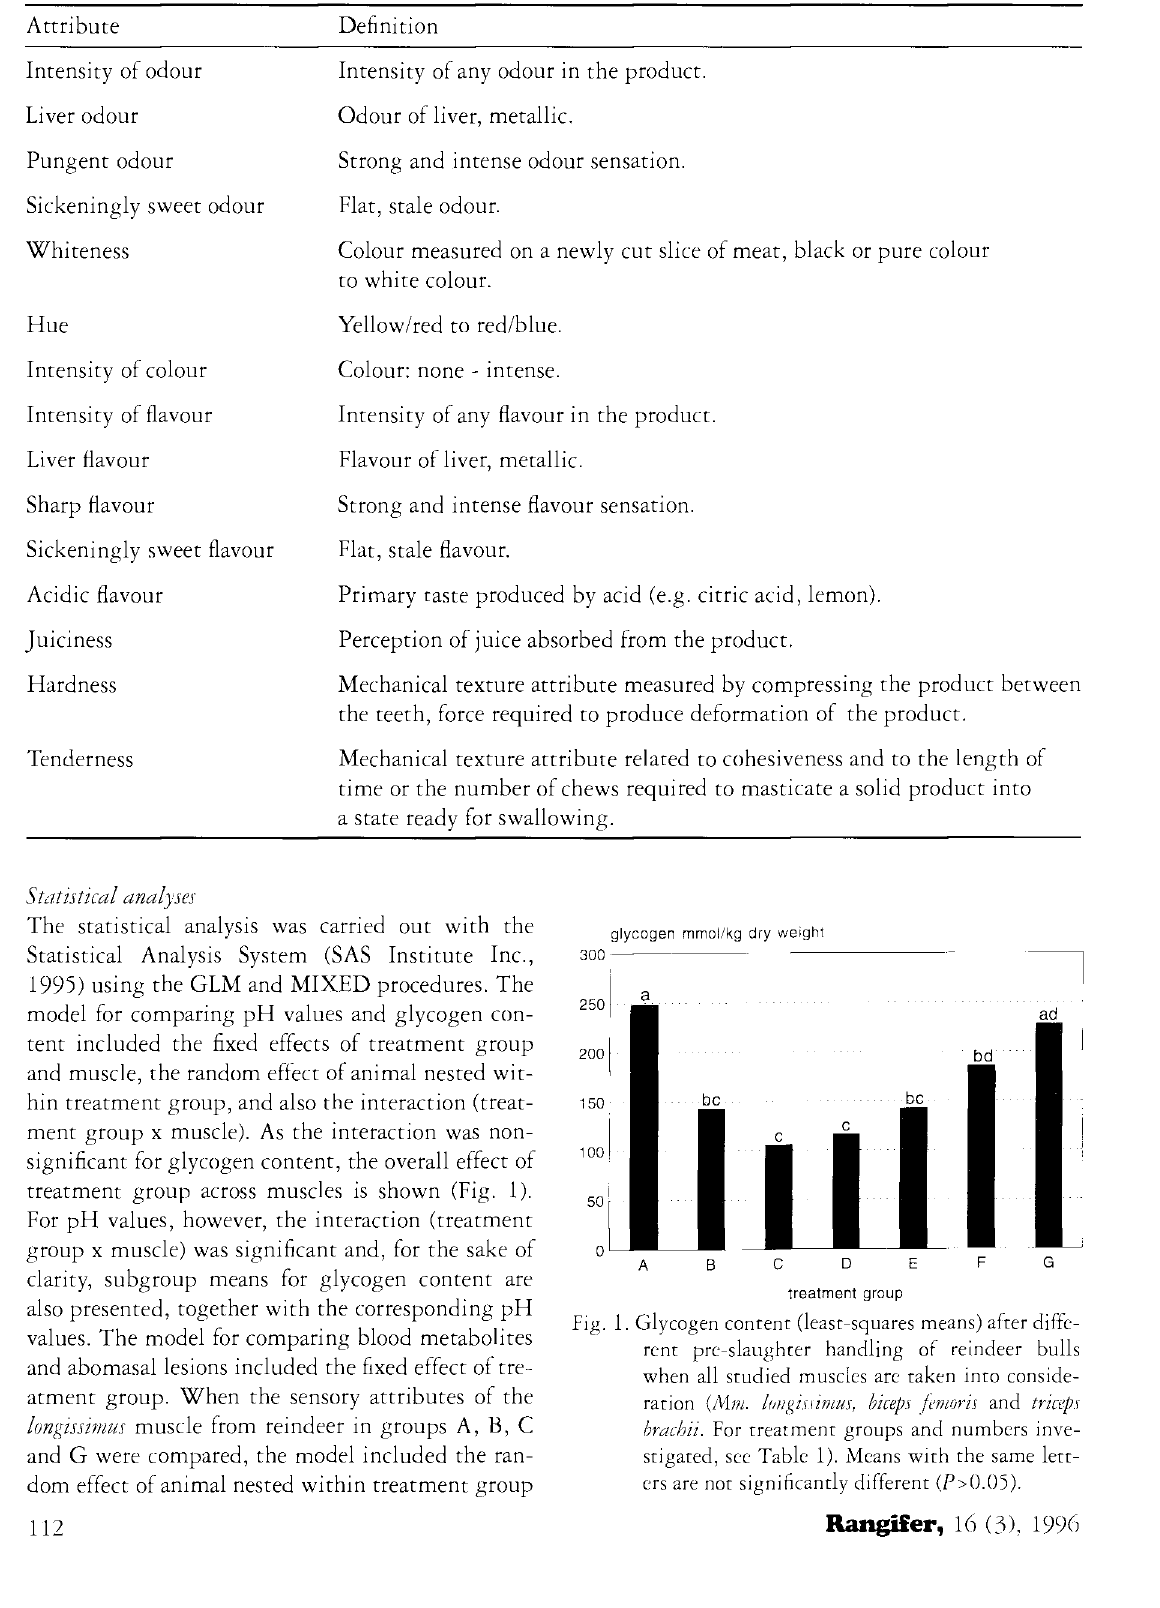
Table 2. Definitions of the sensory attributes used in the sensory profiling of the reindeer meat.